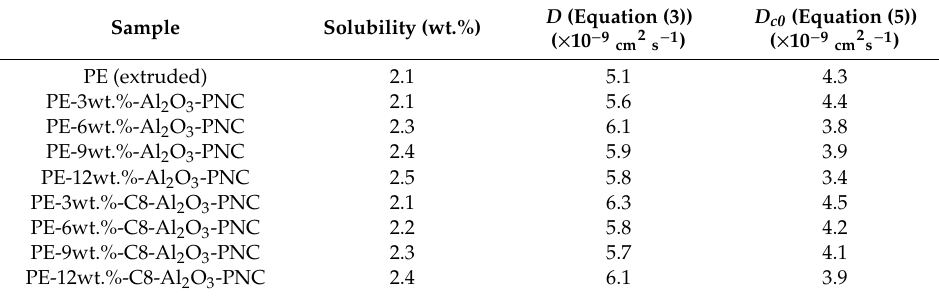
Table 2. Solubility and di ff usivity. Acetophenone desorption data at 21 ◦